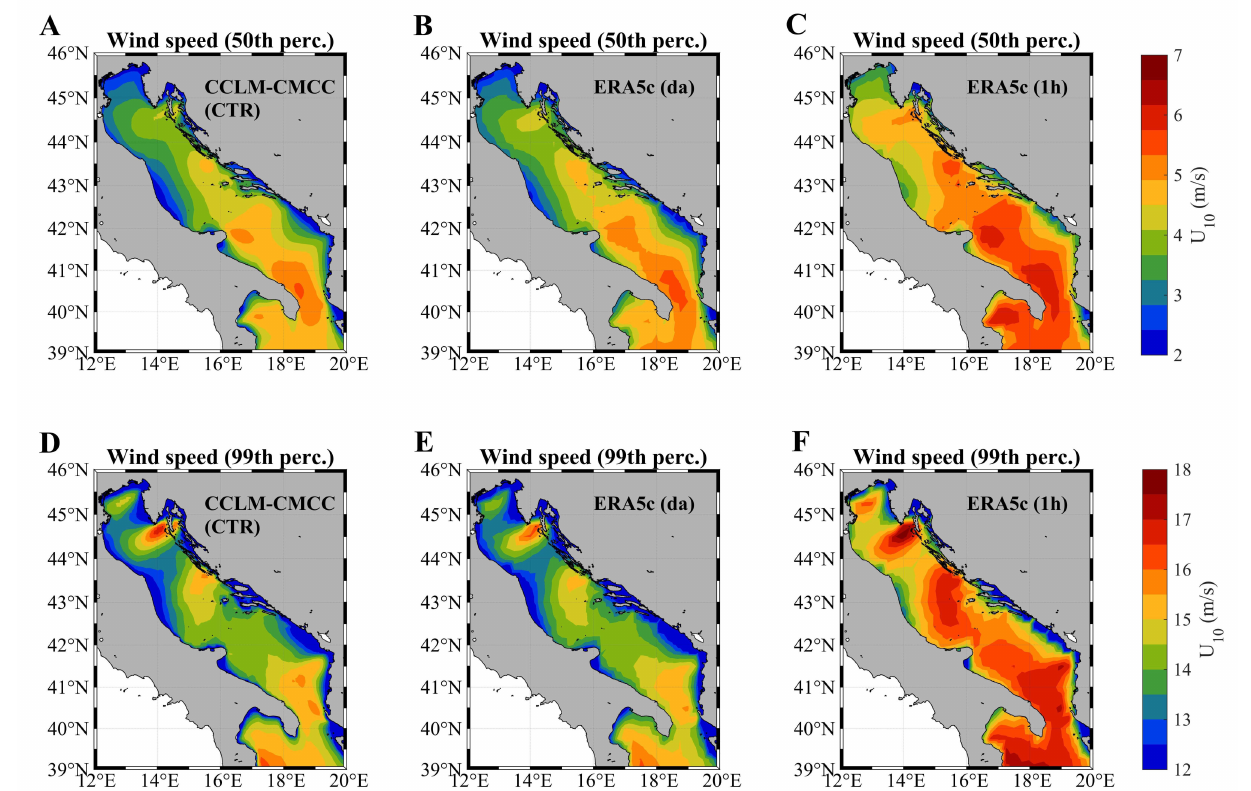
Figure 9. Wind speed climate over the Adriatic Sea and the northern Ionian Sea for the years 1981–2010. Average of annual 50th ( A – C ) and 99th ( D – F ) percentiles of U 10 (in m/s). ( A , D ) CCLM- CMCC data from the control run (CTR); ( B , E ) daily averaged (da) ERA5c data; ( C , F ) ERA5c hourly data (1 h). For clarity, color scales change between ( A – C ) and ( D – F